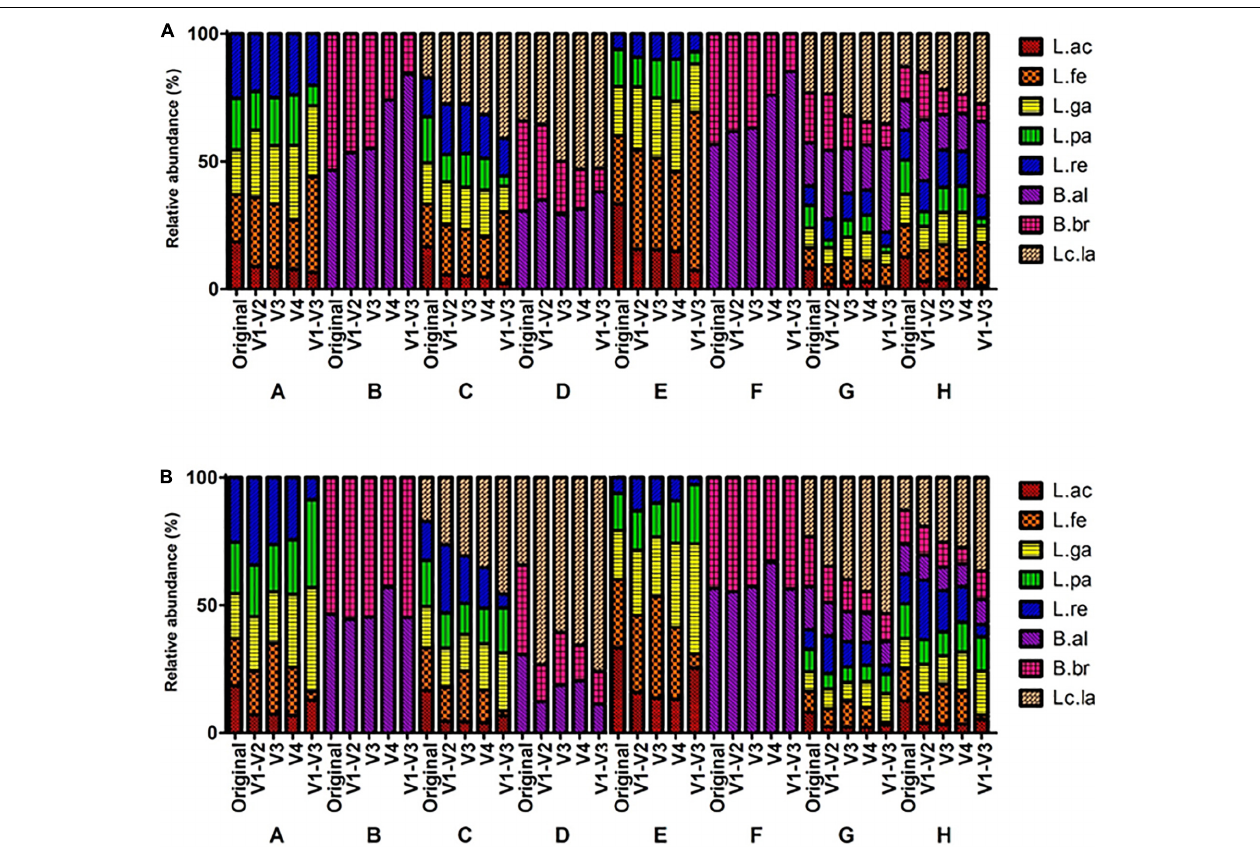
FIGURE 3 | Comparison of mock communities’ microbial profiles based on the sequencing reads from MiSeq and IonTorrent platform. V1-V2, V3, V4, and V1-V3 indicated the amplified variable region of the amplicon. A–H indicated specific mock communities. (A) MiSeq Sequencing profiling of relative abundance on mock communities. (B) IonTorrent Sequencing profiling of relative abundance on mock